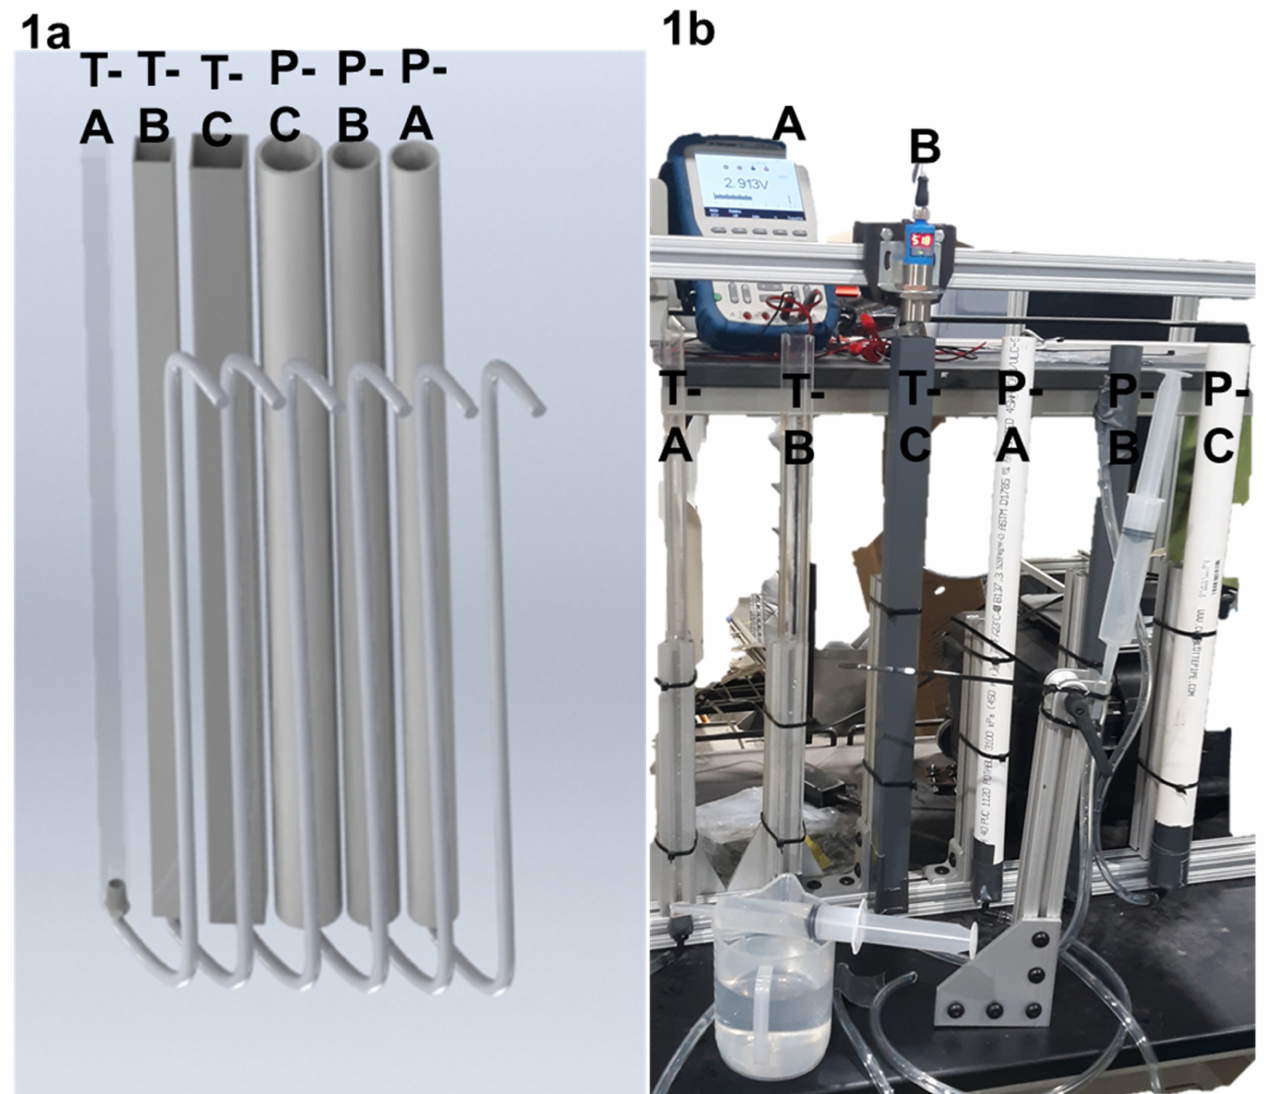
Figure 1. ( 1a ) Experimental set-up sketch, ( 1b ) picture of experimental set-up with ( A ) DSO and ( B ) ultrasonic sensor. All tubes and pipes are labeled with specifications provided in Table